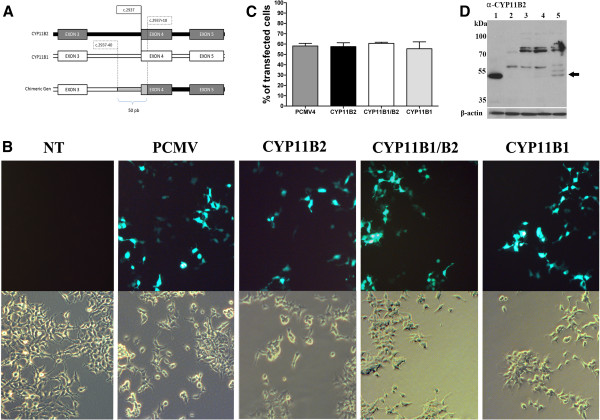
Expression of aldosterone production by ASCE and ASWT in vitro. A) Schematic representation of the CYP11B1/B2 chimeric gene, showing the crossover region between intron 3 of CYP11B1 and exon 4 of CYP11B2. B) A representative image of the transfection efficiency. Green fluorescence (upper panel) and the same bright field (lower panel) of transfected or non-transfected HEK-293 (NT). C) An average transfection efficiency of 50 percent was observed from three independent experiments for each construct. D) A representative Western blot of CYP11B2. Line 1, human adrenocortical adenoma; line 2, NT-HEK-293; line3, PCMV-CYP11B1 transfected HEK-293; line 4, PCMV-CYP11B1/B2; and line 5, PCMV-CYP11B2 transfected HEK-293. Actin was used as a loading control.